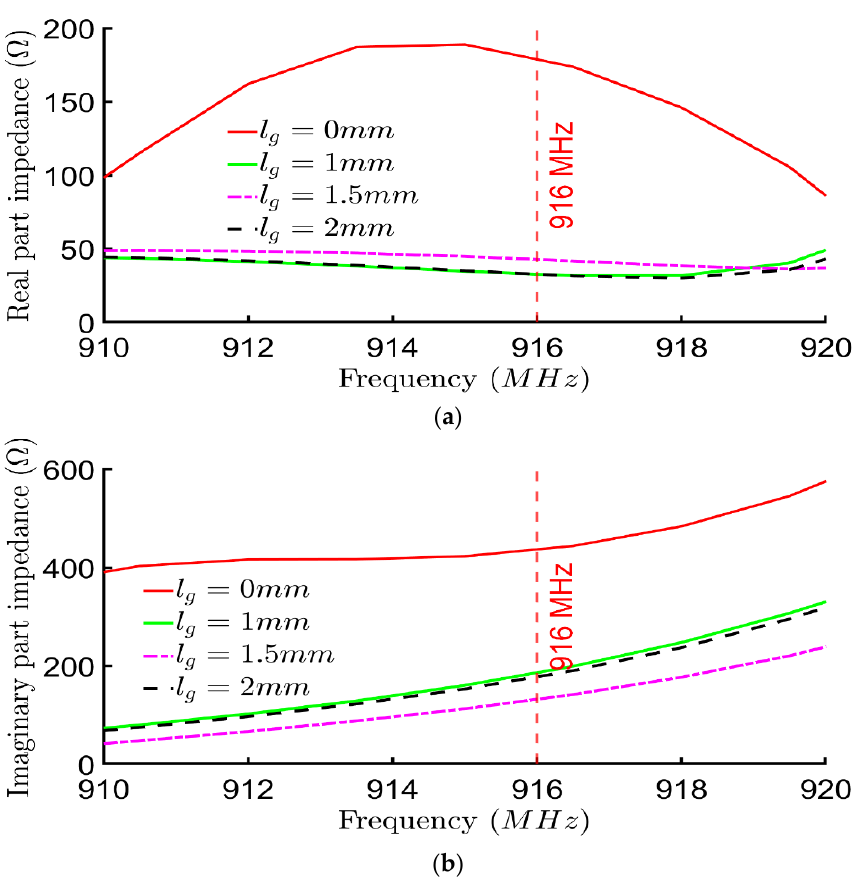
Figure 8. The proposed structure impedance vs. different gap lengths l g : ( a ) The real part of the impedance; ( b ) The imaginary part of the impedance.